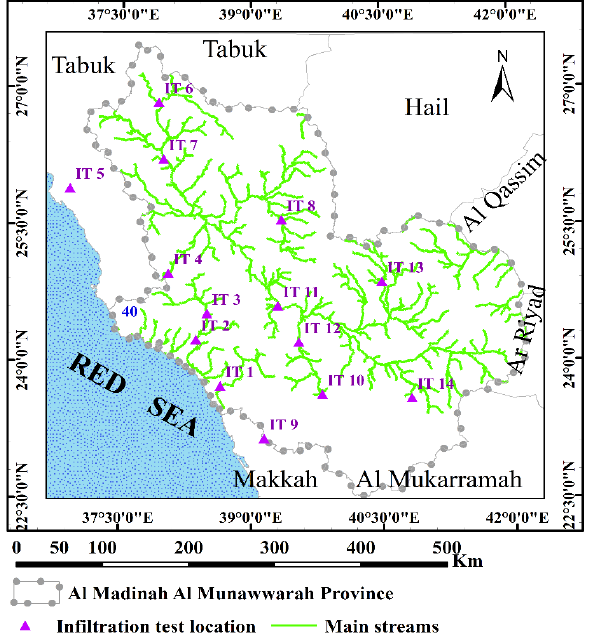
Figure 5. Locations of the infiltration tests.